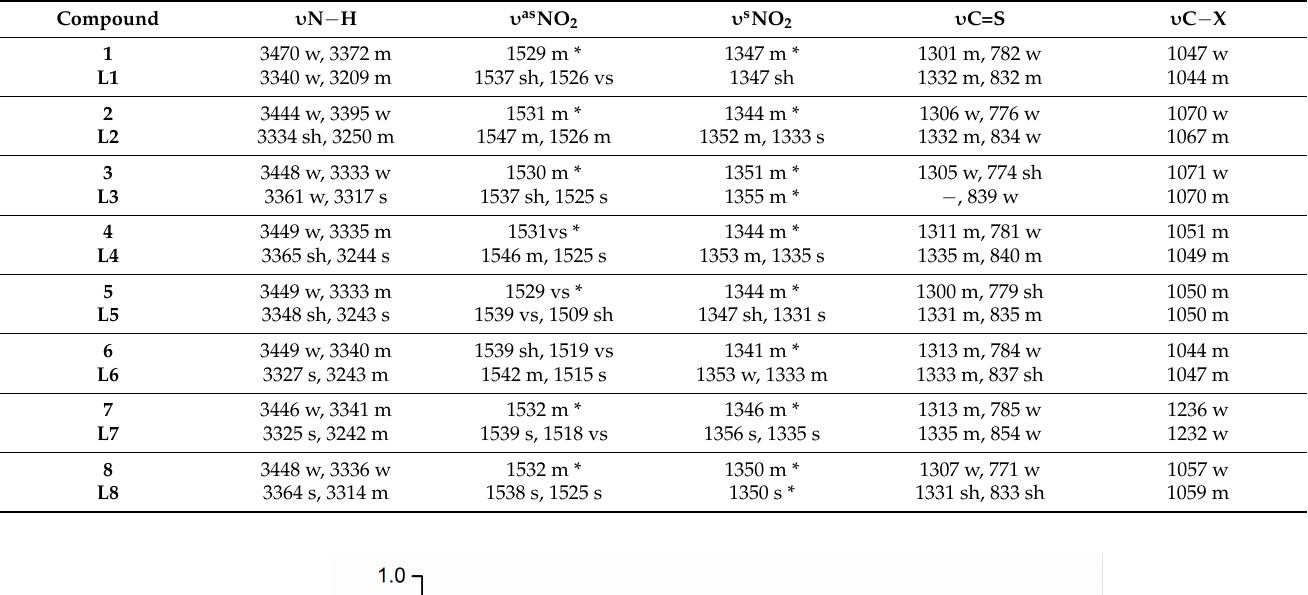
Table 1. Characteristic infrared absorption bands of N − H, NO 2 , C=S and C − X (X = Br, Cl, F, I) groups. Band position in cm − 1 , intensity: w is weak, m is medium, s is strong, vs is very strong, sh is shoulder, as is asymmetric, s is symmetric, * is broad band.